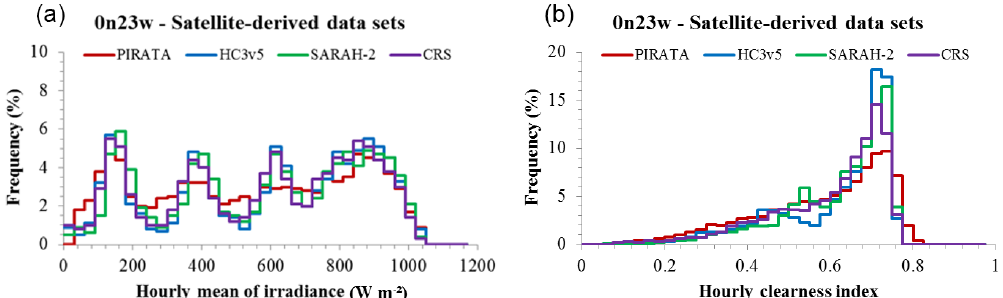
Figure C2. Frequency distributions of PIRATA measurements (red) and data sets (HC3v5: blue, SARAH-2: green, CRS: purple) at 0 ◦ N, 23 ◦ W for E (a) and KT (b) . If the coloured line is above (below) the red one for a given sub-range of values, it means that the data set produces these values too frequently (too rarely) with respect to the PIRATA measurements.